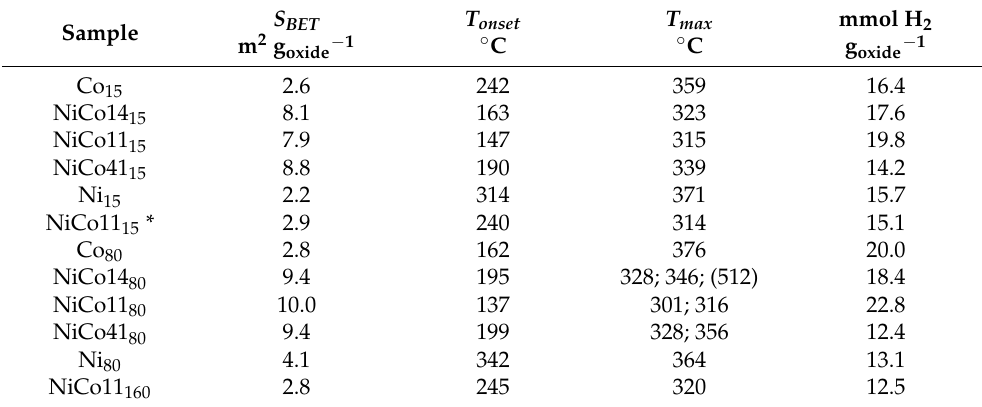
Table 3. Surface area, initial reduction temperatures (T onset ), reduction temperature of maxima (T max ), and H 2 consumption determined during TPR measurements for the Ni-Co catalysts.